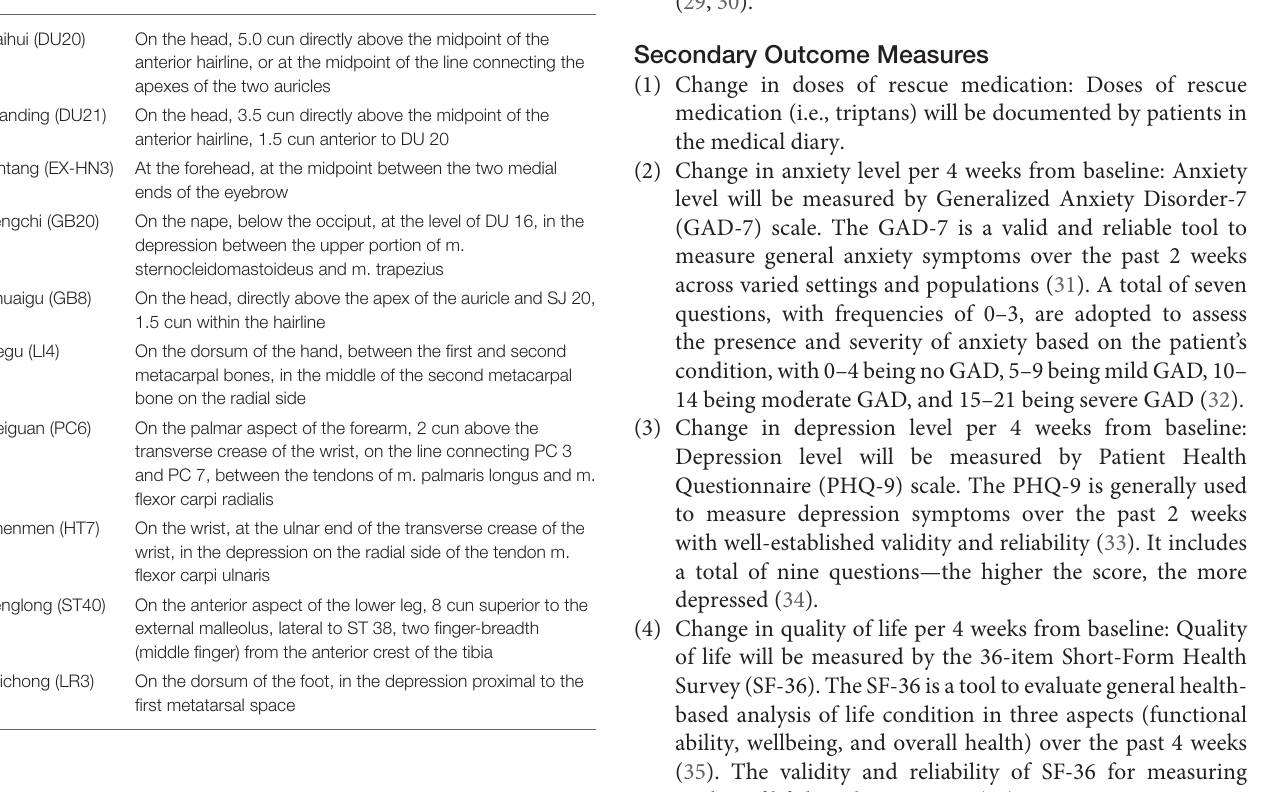
TABLE 2 | Locations of the selected acupoints for treating vestibular migraine.